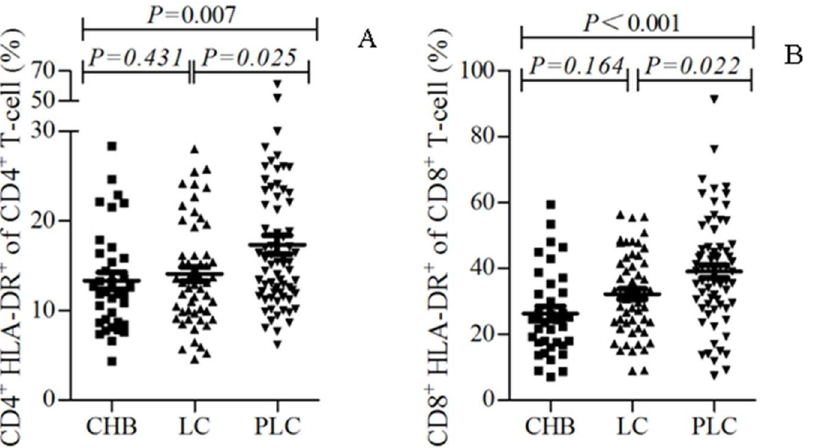
Fig 4. Hyperactivation of peripheral CD4 + and CD8 + T cells in patients with HBV-PLC. Percentages of HLA-DR-expressed cells (HLA-DR%) among the CD4 + T cells (A) and CD8 + T cells (B) of the peripheral blood were comparedbetweenthe patients with CHB, those with HBV-LC and those with HBV-PLC. p < 0.05 was considered